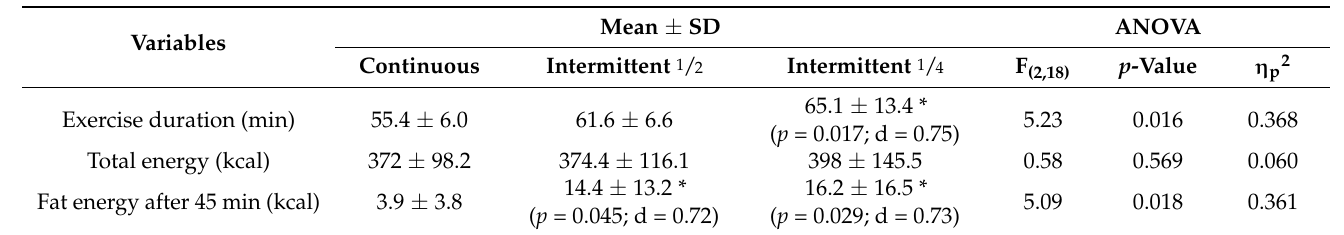
Table 2. Duration and energy expenditure of the three exercise types.